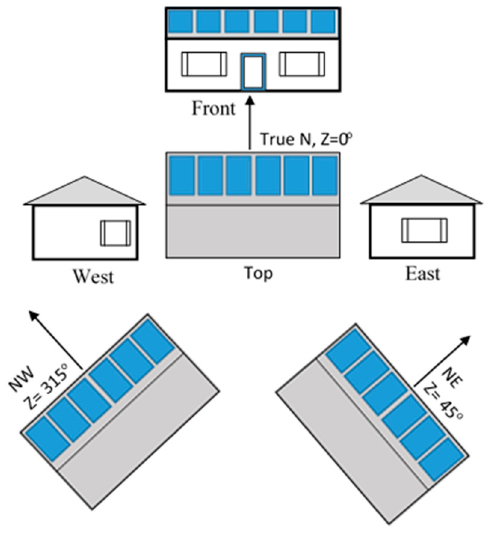
Figure 6. The house model and PV rooftop arrangements.